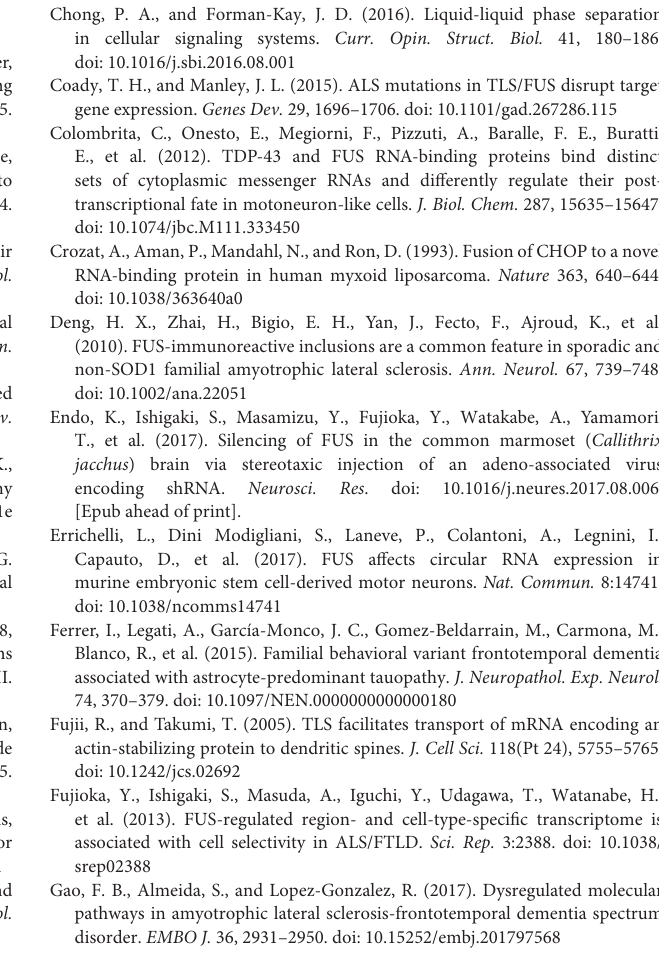
figure design. GS: Conception and design, manuscript writing, and